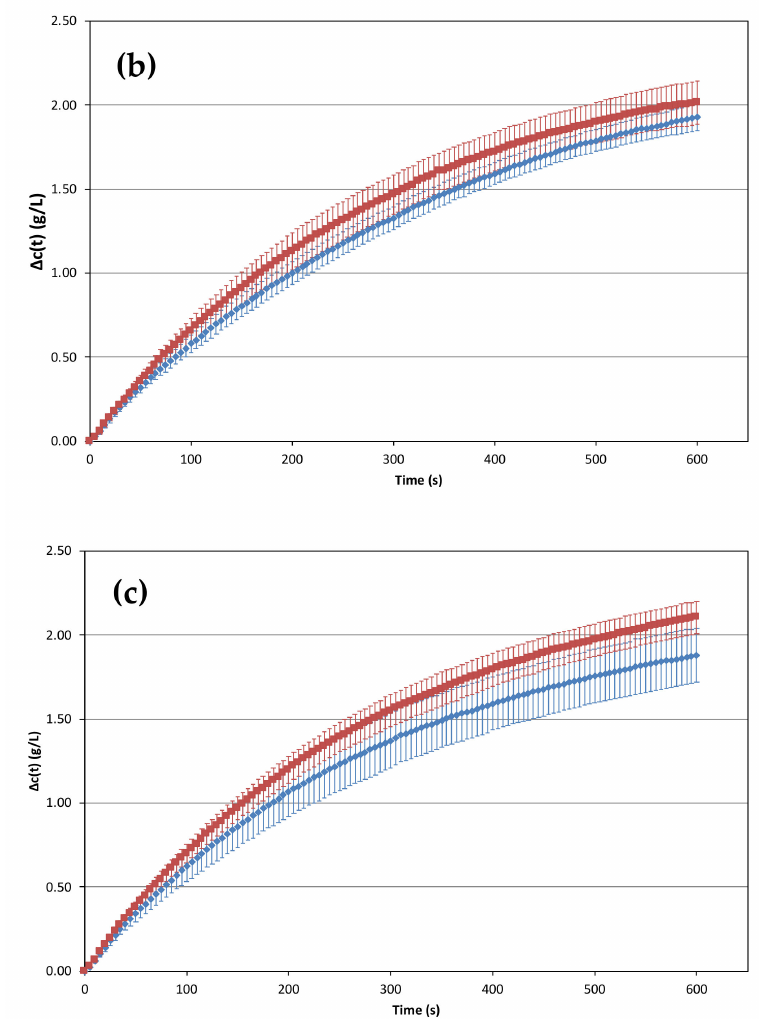
Figure 2. Progressive losses of dissolved CO 2 concentration (g.L − 1 ) during the ten minutes following pouring of each pair of sparkling wine into a flute; ( a ) sparkling wines A13 (blue, n = 12) and A20 (red, n = 10); ( b ) sparkling wines B13 (blue, n = 10) and B20 (red, n = 9); ( c ) sparkling wines C13 (blue, n = 11) and C20 (red, n = 10). Each point of each curve corresponds to the mean of values recorded from at least nine successive pourings. Error bars corresponds to standard deviations of the values obtained by the successive data